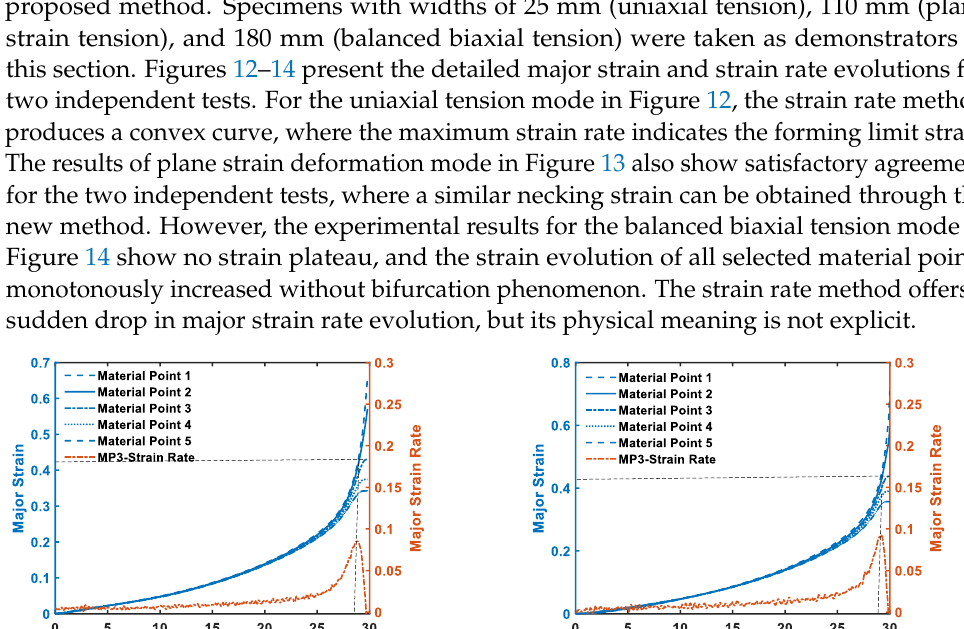
Figure 11. The major strain and strain rate evolution for two independent tests on a 30 mm wide specimen: ( a ) the first test; ( b ) the second test.